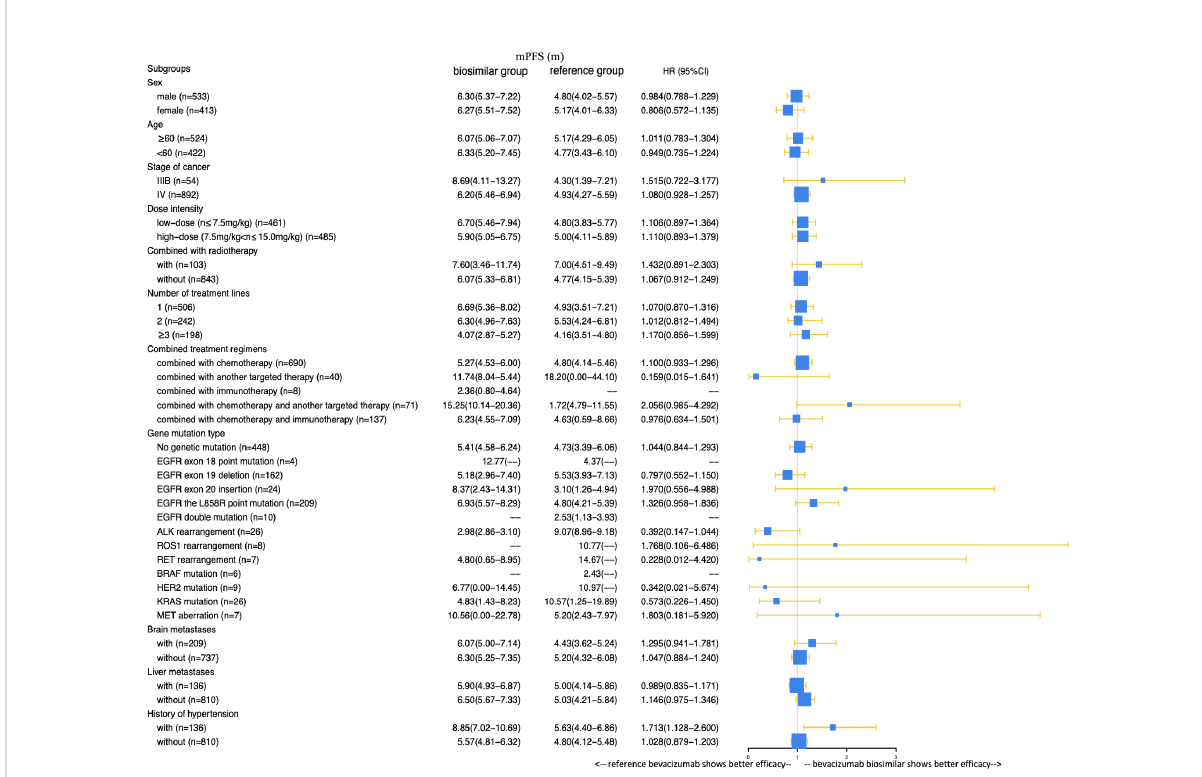
FIGURE 3 Comparison of the effects of bevacizumab biosimilar and reference bevacizumab on the PFS of each